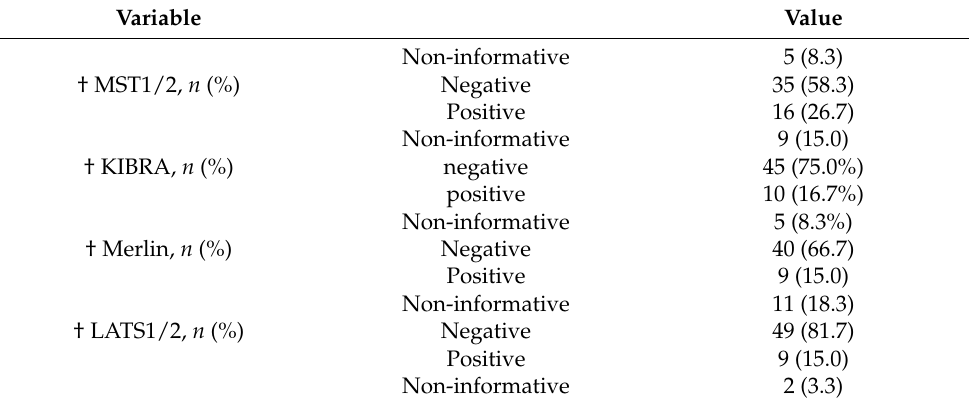
FIGO: International Federation of Gynecology and Obstetrics; LVSI: Lymph vascular surface invasion; YAP: Yes-associated protein 1; p -Yap: Phosphorylated Yes-associated protein 1; MST: Mammalian STE20-like kinase; KIBRA: Kidney and brain protein; Merlin—also called Neurofibromin 2; LATS: Large tumour-suppressor kinase. * The primary tumour size was unmeasurable in four cases. † Non-informative samples exist because of tissue loss in tissue microarray